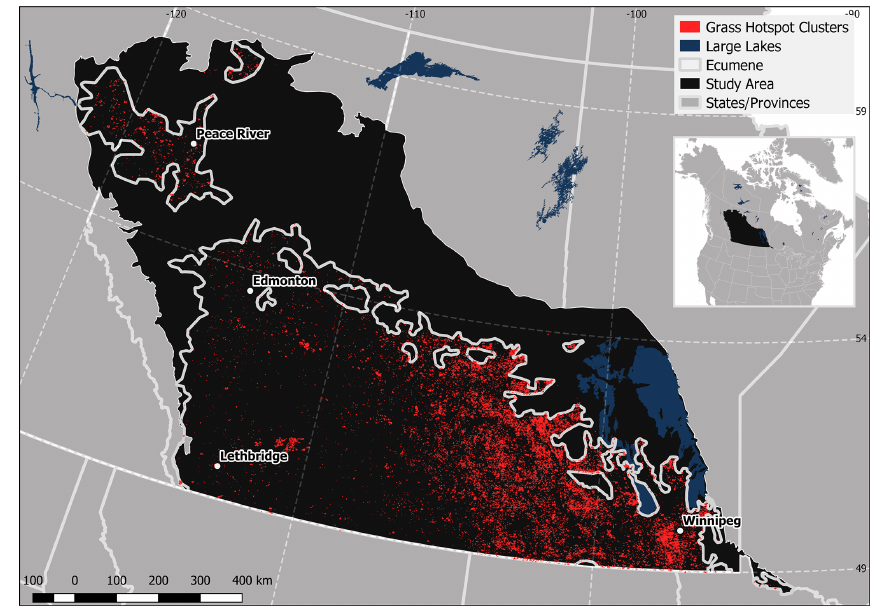
Figure 2. Grass fire MODIS (MOD14A1 and MYD14A1) (Giglio, 2015) hotspot clusters in the study area from 2002–2018. These hotspots have been screened for persistent industrial heat sources and clustered as described in the methods. The study area extends past the ecumene to ensure all minor areas of grass and agriculture are included. However, the vast majority of hotspot clusters are present within the ecumene.